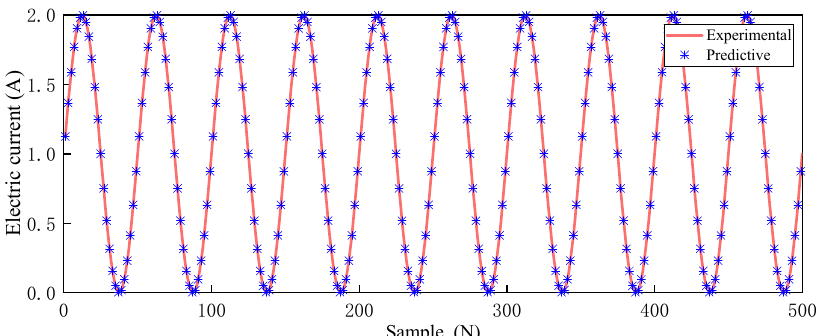
Figure 9. Verification of training data for ANFIS inverse dynamics model.